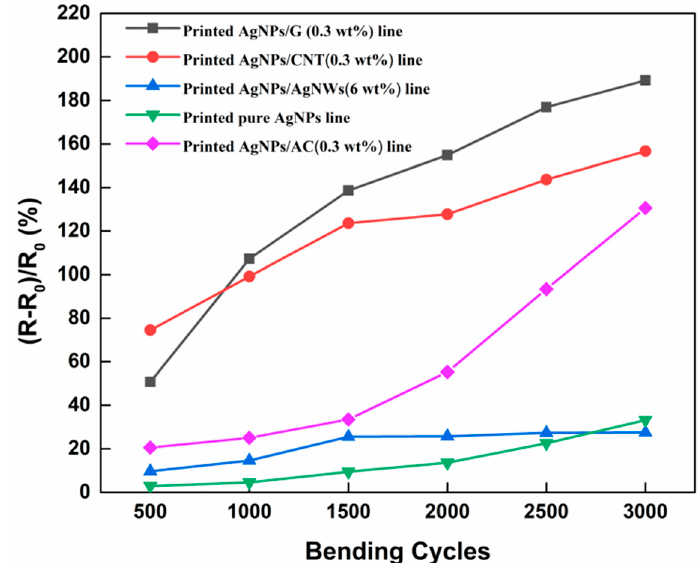
Figure 6. The change of resistance in composite electrode during bending.